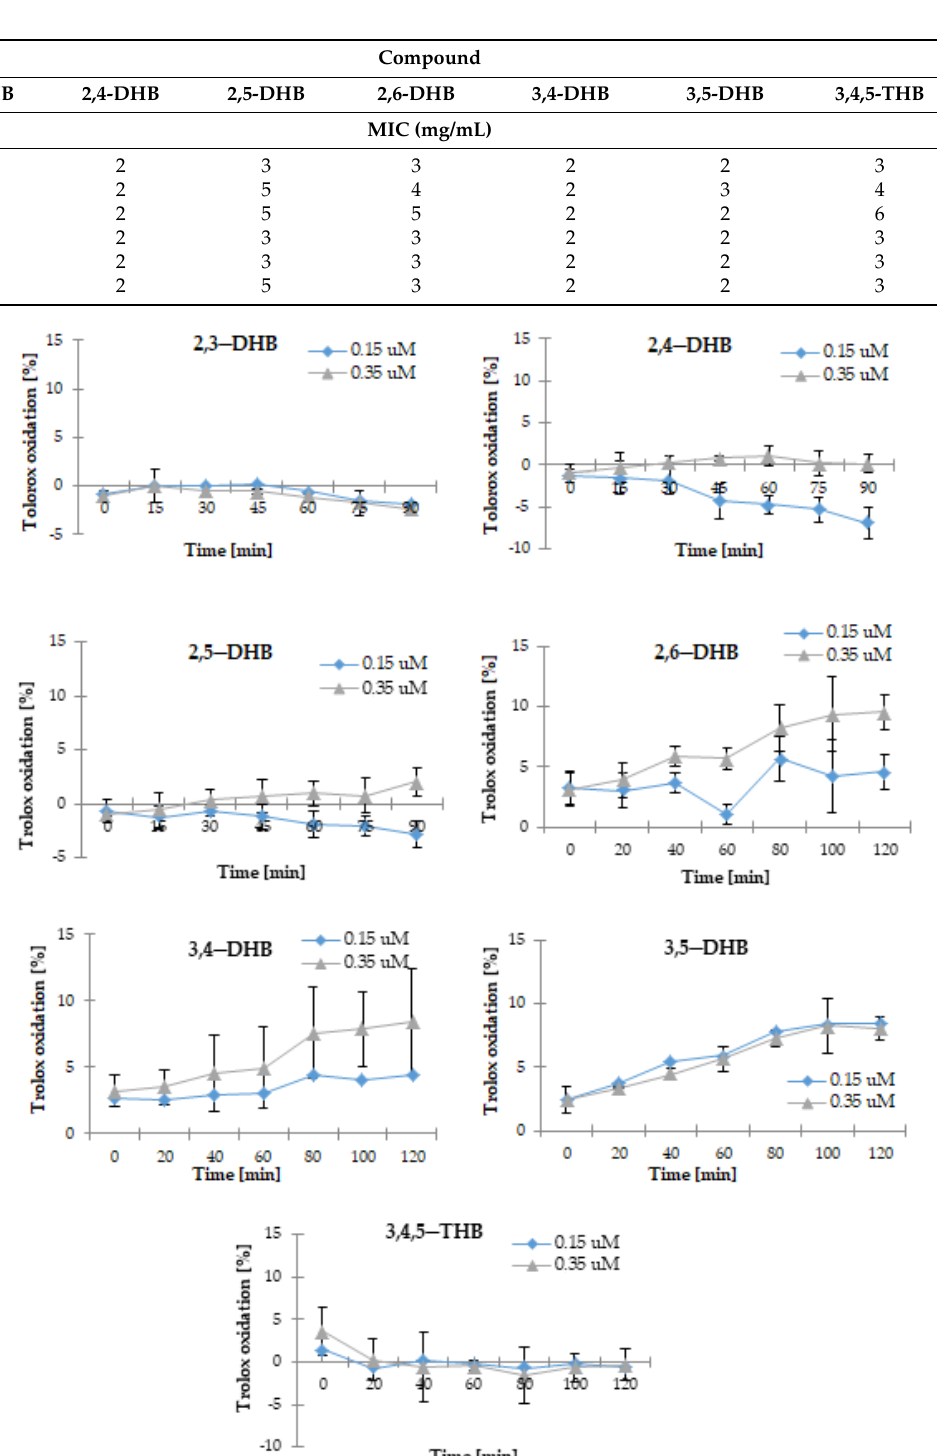
Figure 5. The degree of Trolox oxidation (%) by tested hydroxybenzoic acids at concentrations of 0.15 and 0.35 μM (methanolic solutions), measured within 90 or 120 min. Mean values from three independent experiments ± SD are shown.